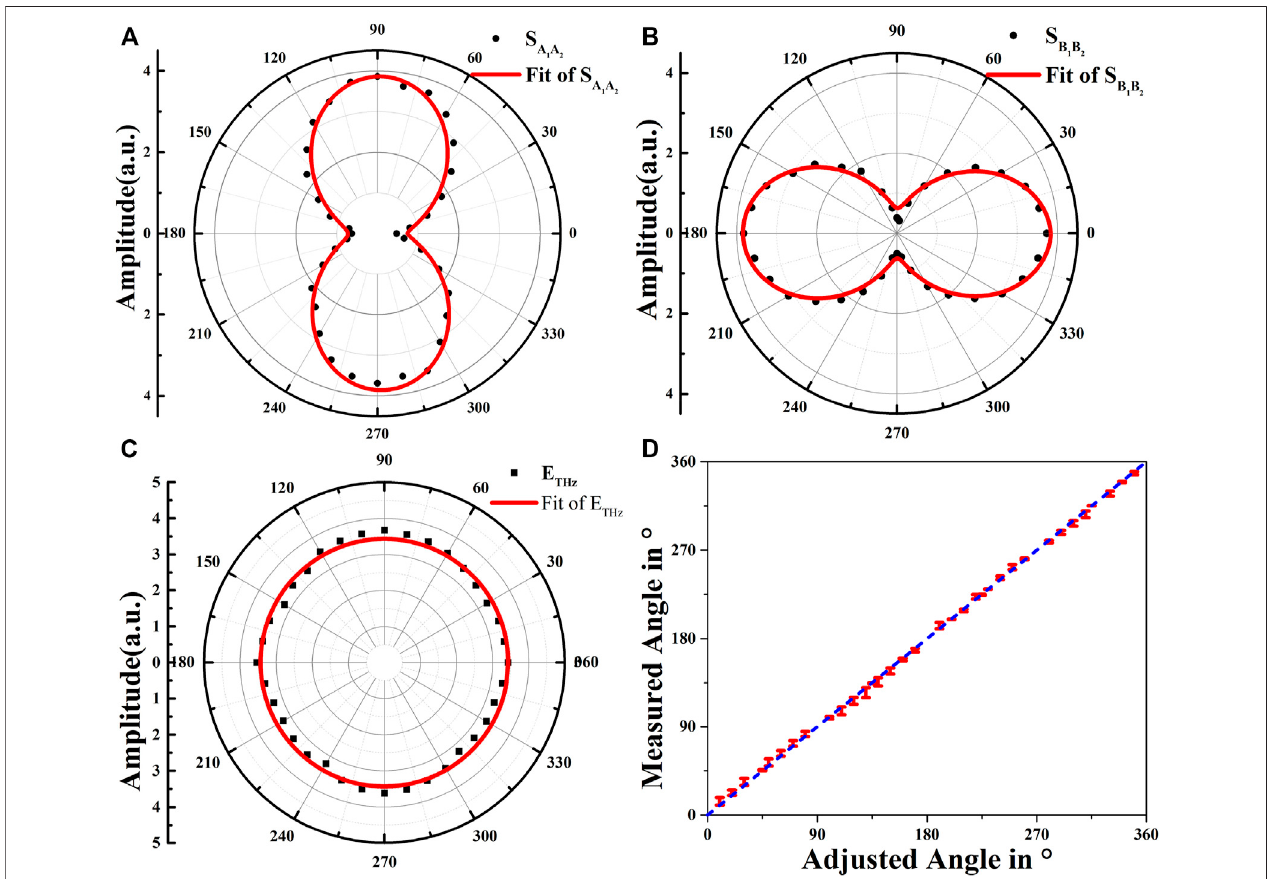
Figure 5B . The spectral DOP( f ) is greater than 99% in the 0.1THz-1.5 THz spectral